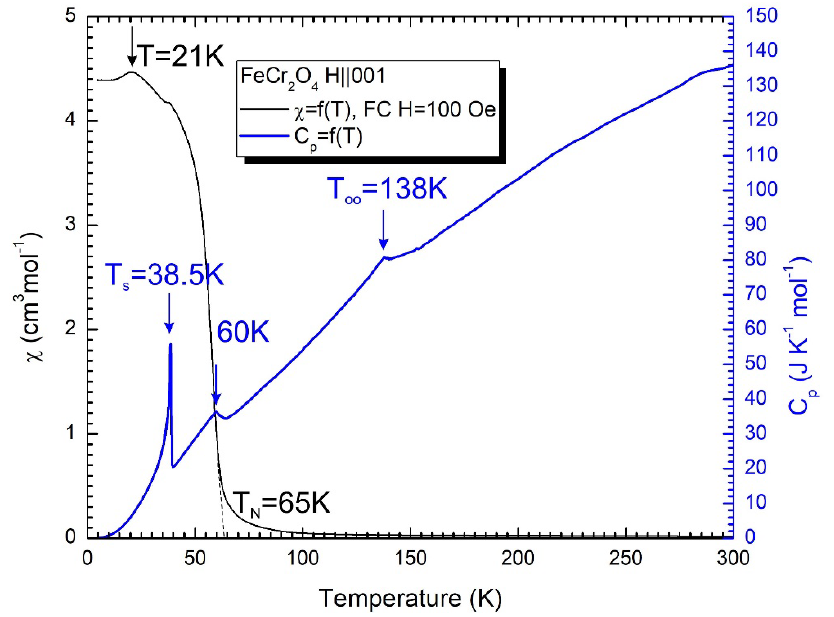
Figure 5. The temperature dependence of magnetic susceptibility and specific heat for FeCr 2 O 4 . Black line is the result of the field-cooled (FC) at H = 100 Oe measurements, respectively, the blue line represents the specific heat data.